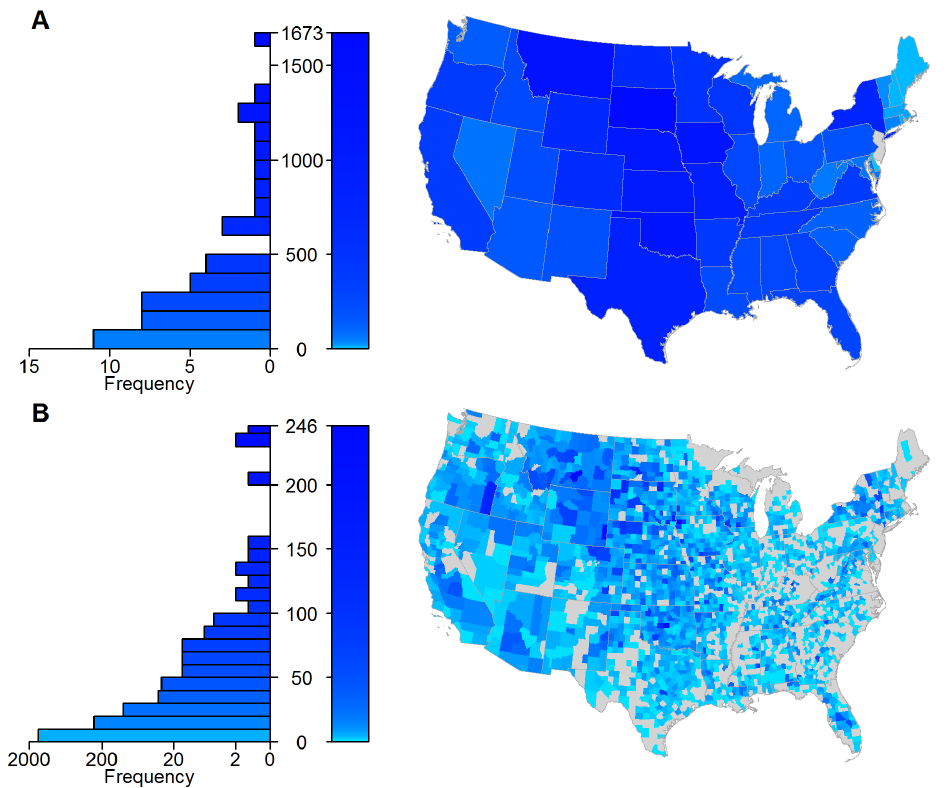
Figure 3. Out-degree distributions of the cattle movement network from a 10% sample of ICVIs. The network is aggregated into (A) state and (B) county nodes. The left-hand graphs show the frequency distribution of node out-degrees, while the maps show the value for that area. A logarithmic color scale is used to differentiate high (dark blue) from low (light blue) out-degree. Counties with no sampled out-shipments are indicated in gray.